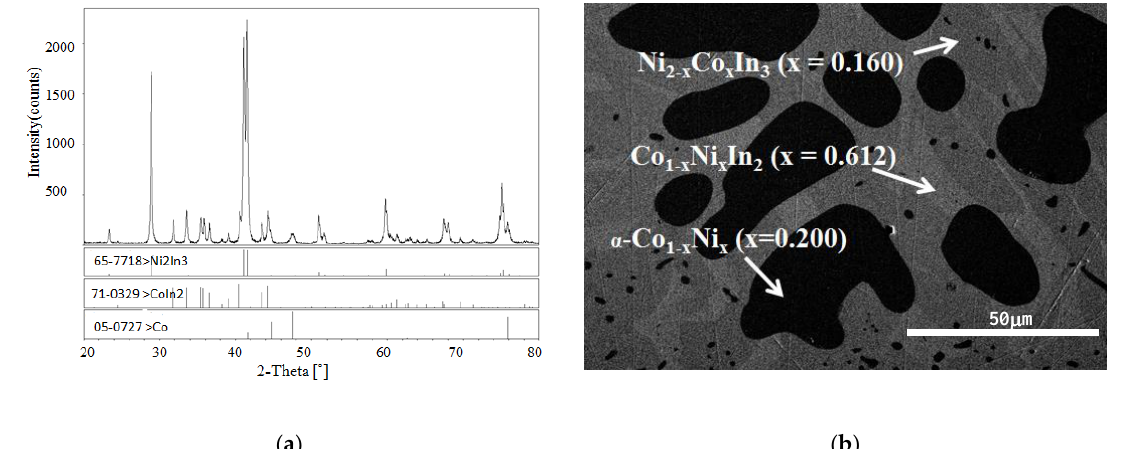
Figure 4. ( a ) XRD pattern and ( b ) BSE micrograph of No. 26 (Co28Ni24In48).